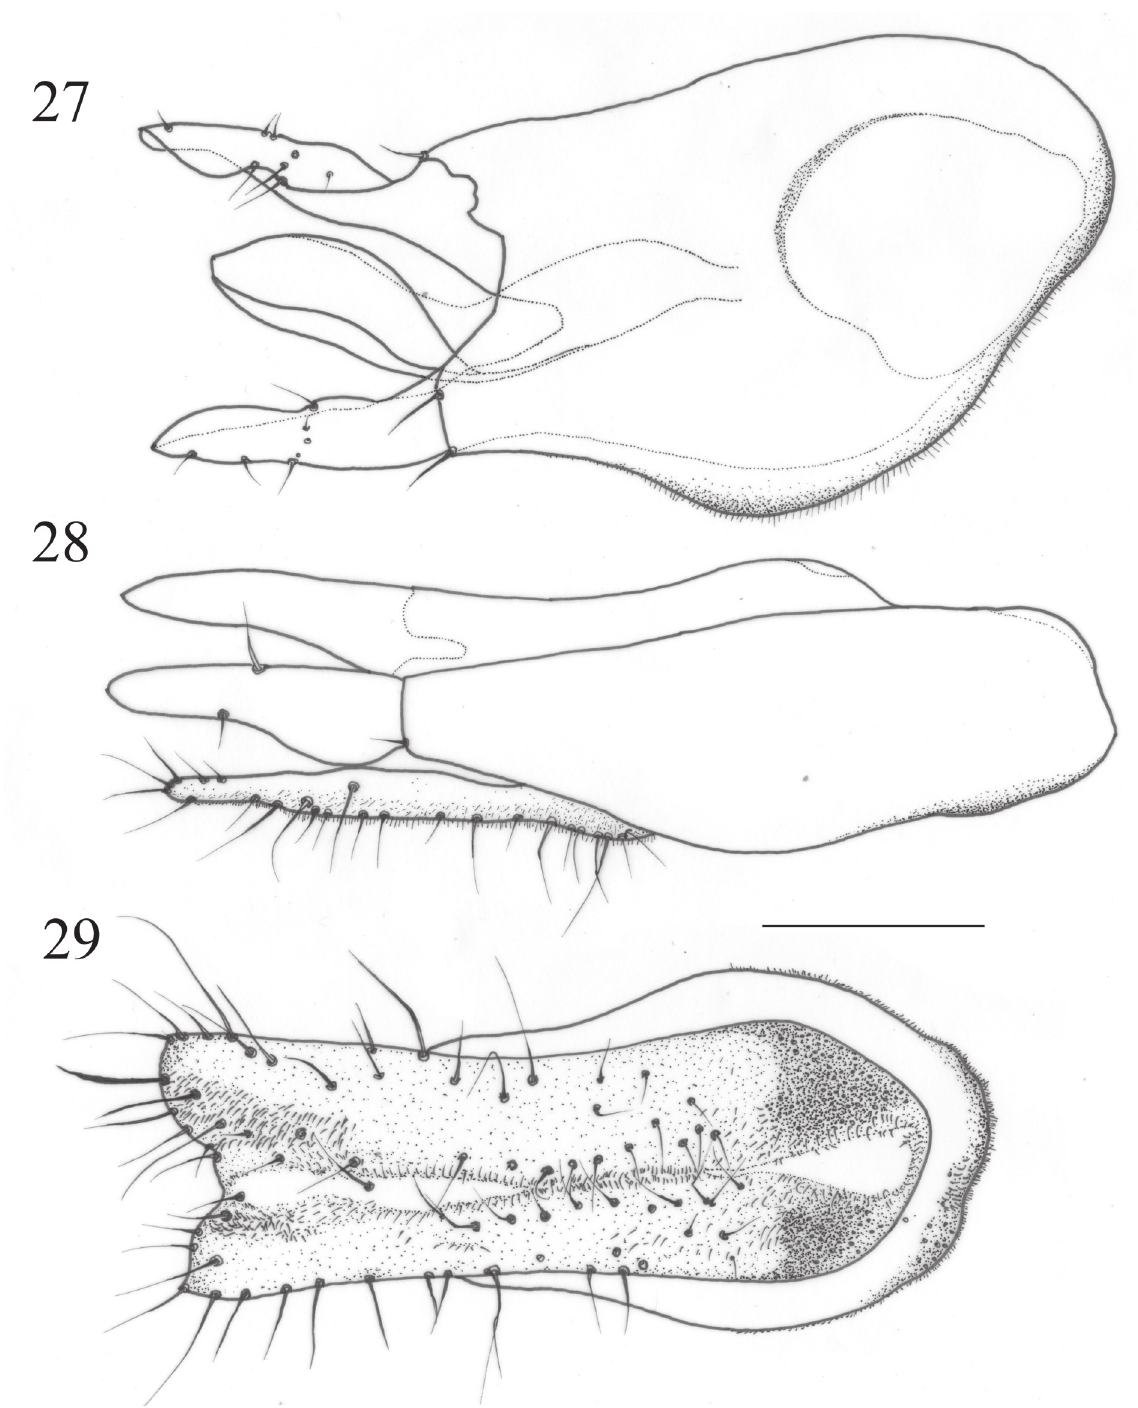
Figs 27–29. Thinophilus spinatoides sp. nov., ♂, terminalia. 27 . Genital capsule, ventral view. 28 . Genital capsule, lateral view. 29 . Genital capsule, dorsal